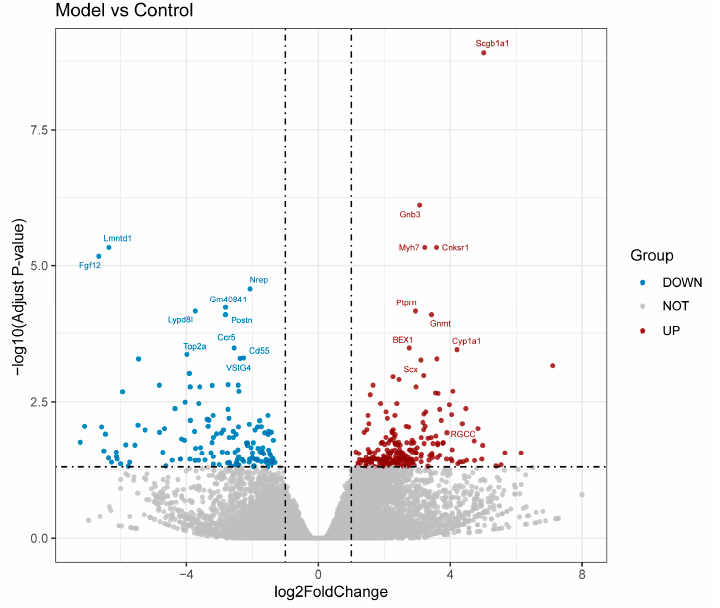
Figure 5. Volcano diagram of RNA-Seq results. Red dots indicate upregulated genes, blue dots downregulated genes, and grey dots indicate genes with no signi fi cant change.